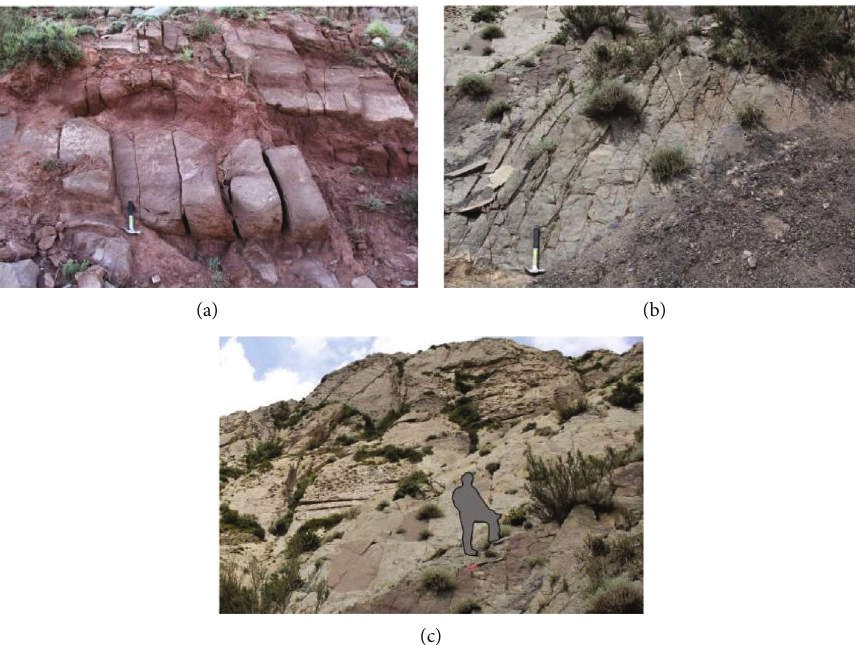
Figure 6: Typical outcropping fractures in the Dibei area. (a) Fractures are only developed in sandstone; they stop at the interface between sandstone and mudstone in the Kalazha Formation of the Jurassic. (b) Typical conjugate shear fractures in the Ahe Formation of the Jurassic. (c) Large-scale shear fractures extending tens of meters in the Ahe Formation of the Jurassic.